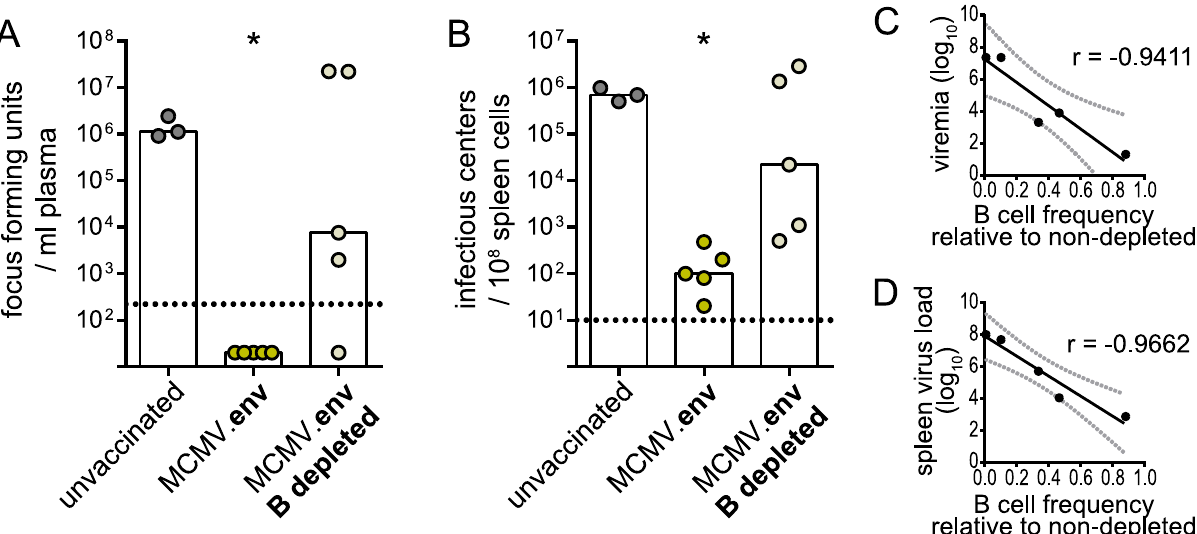
Fig 11. B cell depletion abrogates protection. CB6F1 mice were immunized once with MCMV.env and depleted of B cells by injection of an anti- CD20 antibody. Four days later, mice were infected with 5 000 SFFU FV. MCMV.env immunized mice without B cell depletion and unvaccinated mice served as controls. Viral loads in plasma were analysed ten days after FV infection (A), viral loads in spleens were analysed three weeks after FV challenge infection (B). B cell depletion efficacy was analysed ten days after FV infection in peripheral blood, and linear correlation analysis of B cell depletion efficacy and viremia (C) or spleen viral loads (D) was performed. Data were obtained in one experiment, each dot indicates one mouse, bars indicate median values, grey lines indicate 95% confidence intervals. Statistically significant differences compared to unvaccinated mice are indicated by � ( P < 0.05, One Way ANOVA on Ranks, Dunn’s post